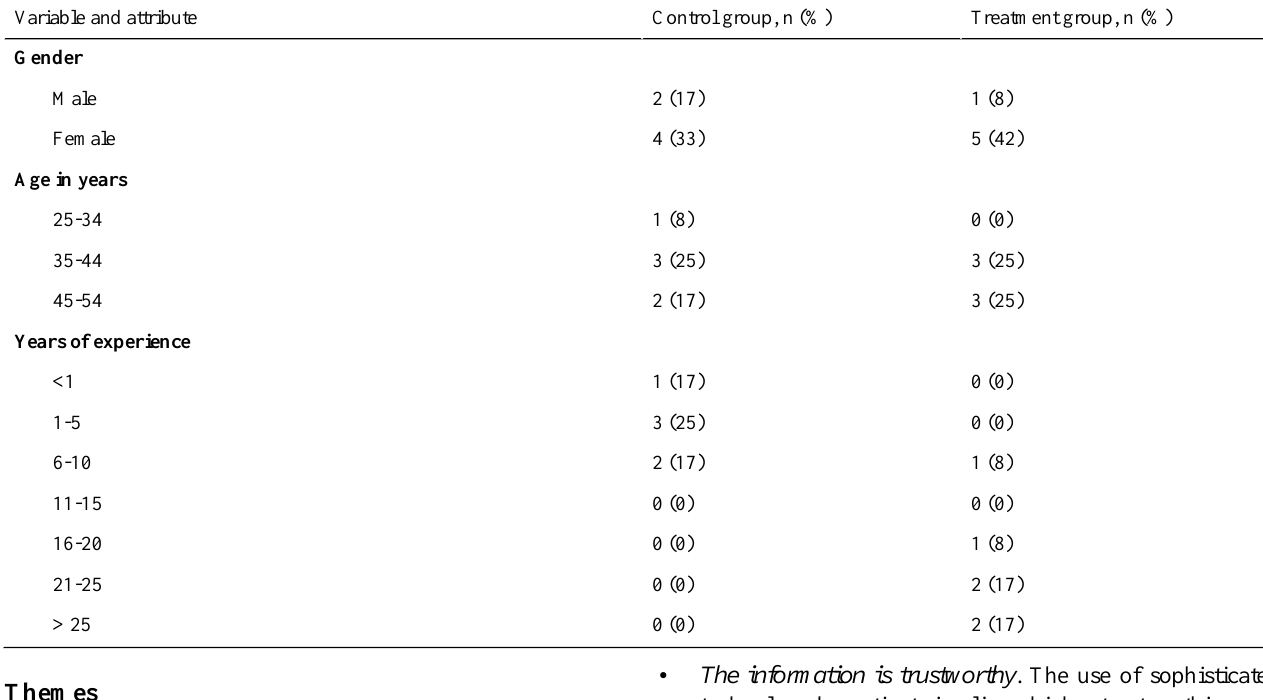
Table 6. Demographics of participants (12